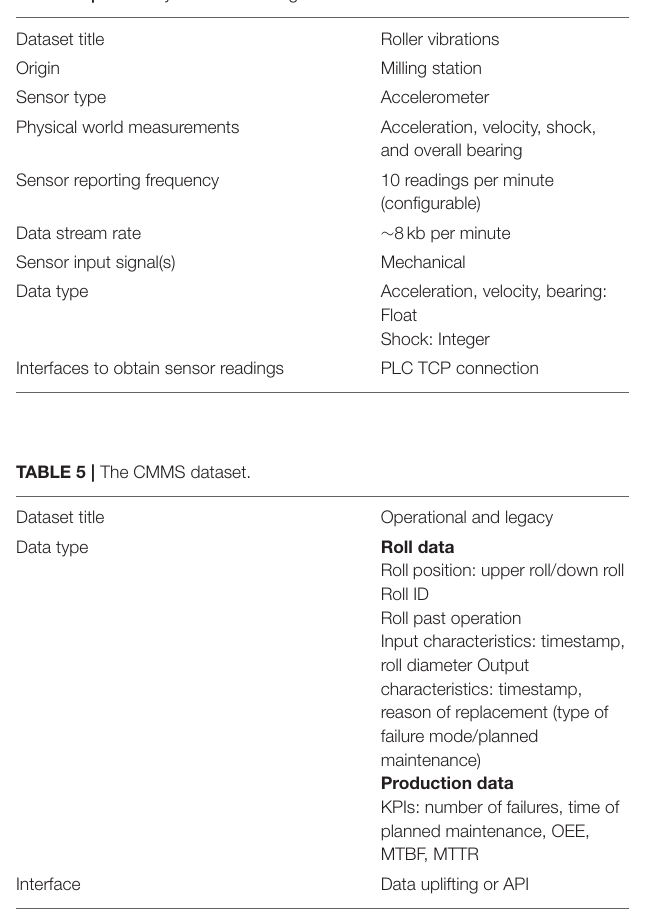
TABLE 6 | Technology